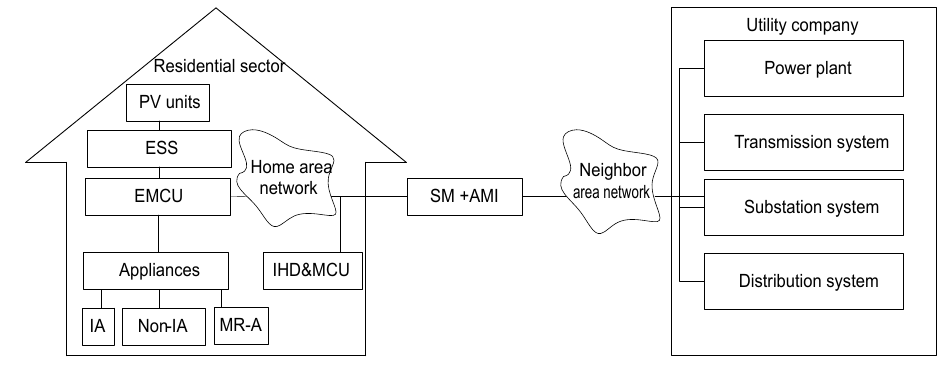
Figure 3. Smart power